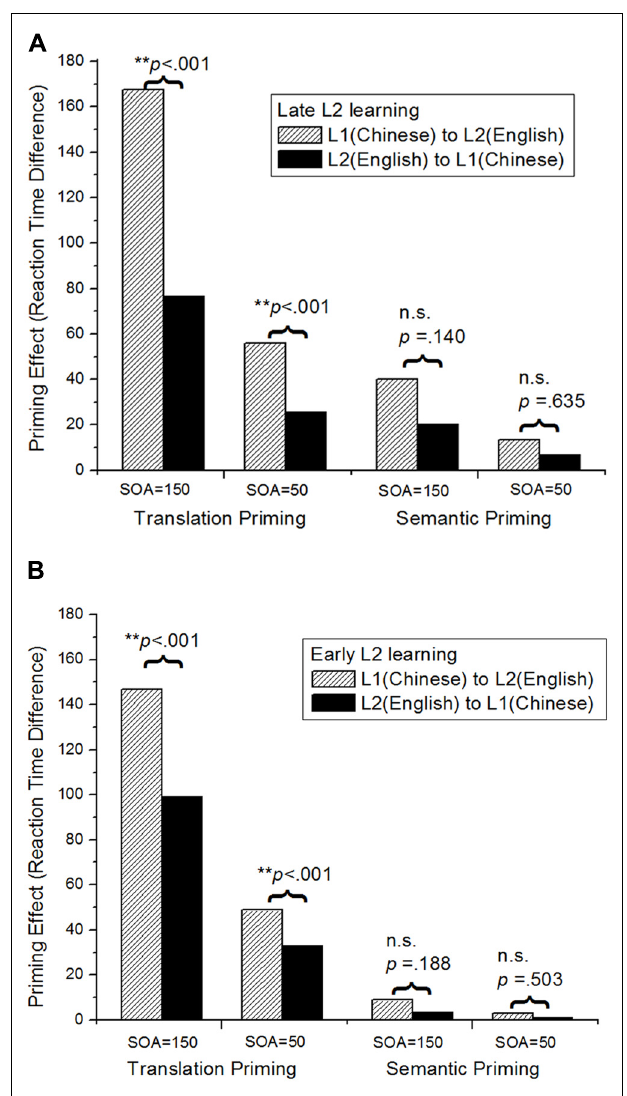
FIGURE 5 | Cross-language priming and priming asymmetry effects shown in DevLex-II: (A) late L2 learning; (B) early L2 learning. Priming effects are calculated by subtracting the RTs of related word pairs from the RTs of unrelated word pairs. SOA represents the stimulus onset asynchrony.The p values indicate the significance level of the priming asymmetry under the different conditions (paired-samples t -test of the 20 simulations under each condition: **significant priming asymmetry; n.s., not significant) (adapted from Zhao and Li, 2013, reproduced with permission from Cambridge University